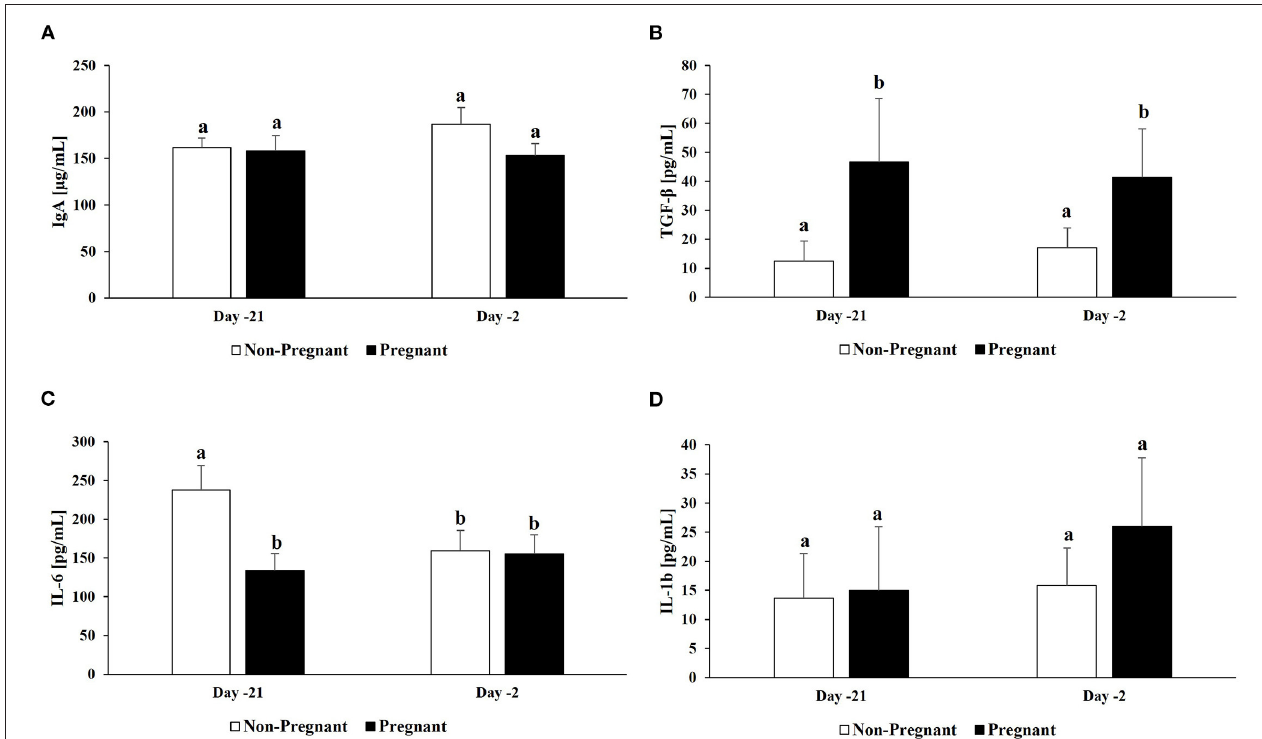
FIGURE 2 | Cytokine concentrations in uterine samples. For a subset of cows ( n = 10; n = 5/group), cytokine concentrations were determined in uterine samples: (A) IgA. For all cows ( n = 20; n = 10/group), cytokines concentrations were determined in uterine samples: (B) TGF- β , (C) IL-6, and (D) IL-1b. Non-pregnant cows are indicated by white bars and pregnant cows by black bars for both d − 21 and − 2. Different superscripts denotes significant differences ( P ≤ 0.05).